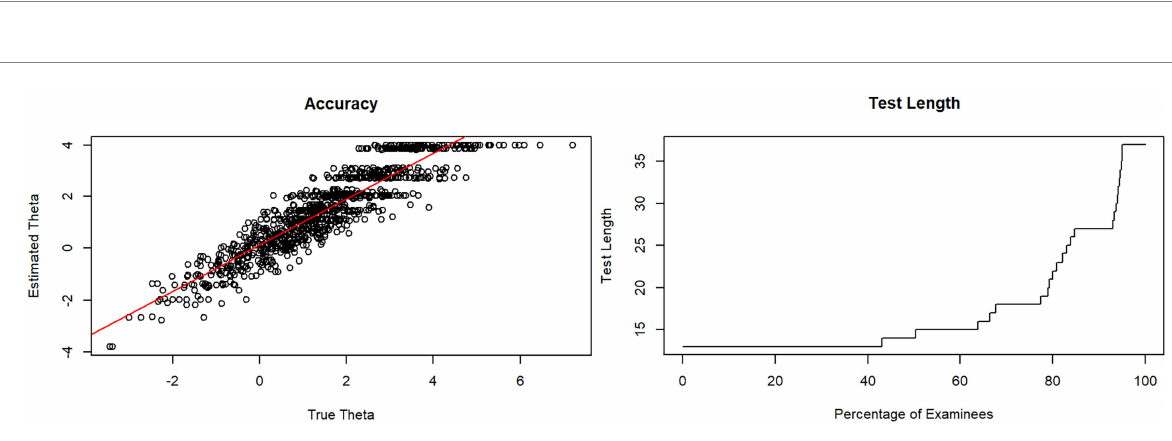
FIGURE 3 Test length and accuracy of SinnL-CAT in a simulation of 1,000 test executions with stopping rules SE = 0.5 and length = 37 items.